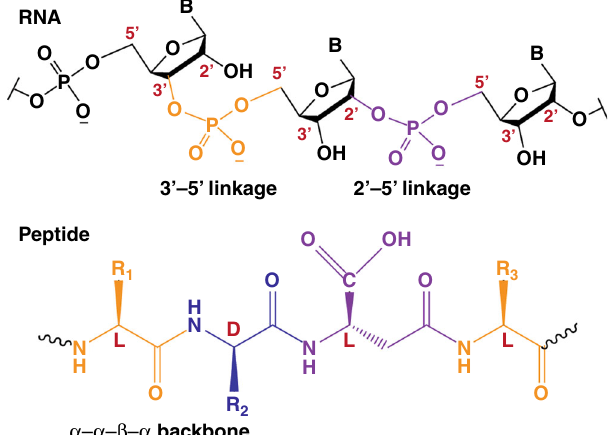
Fig. 1 illustration of RNA and peptide molecules with heterogeneous